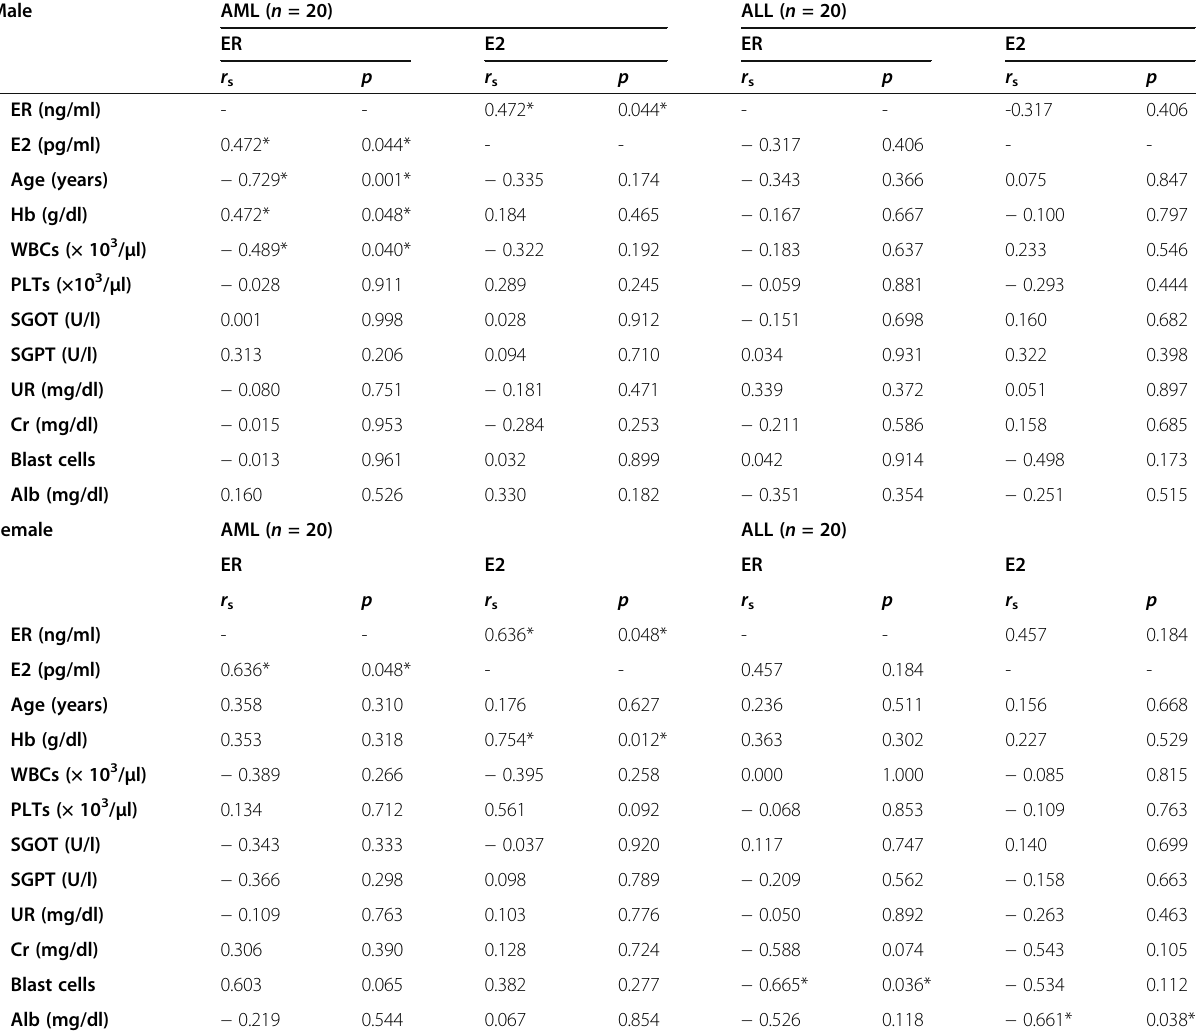
Table 6 Correlation of ER and E2 with different biochemical and hematological parameters in male/female groups Male